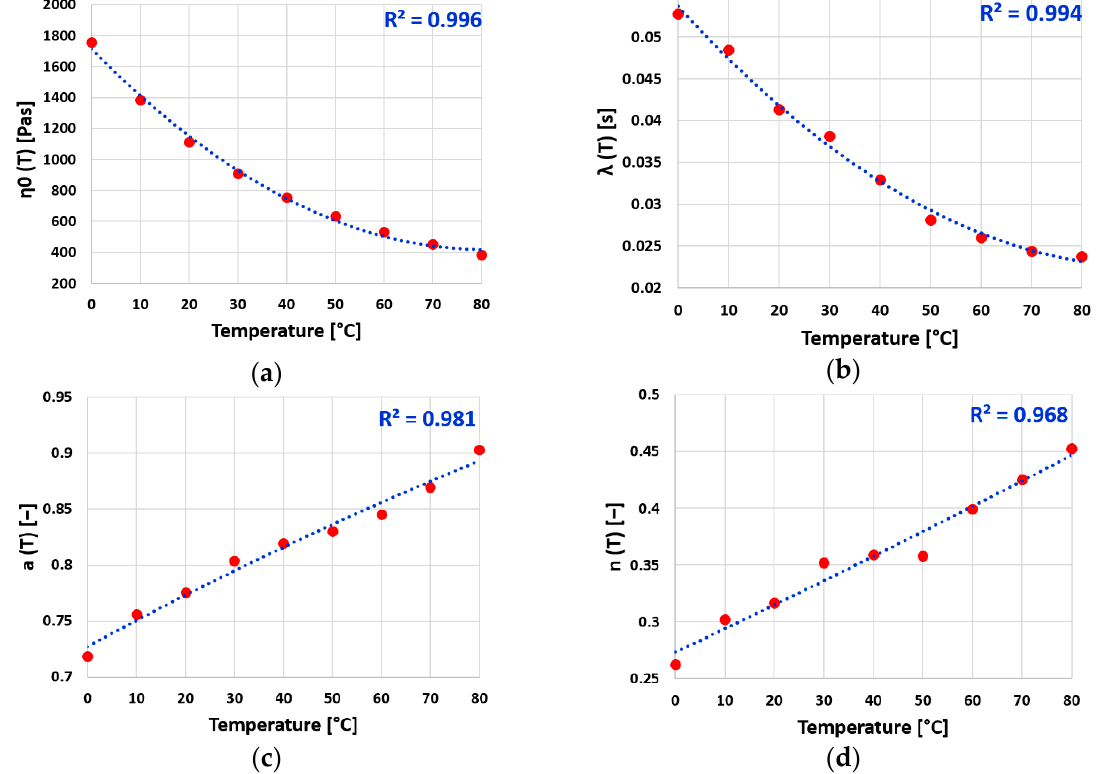
Figure 4. Estimated model parameters (red dots) and fitted model parameter curves (dotted lines) for ( a ) zero-shear dynamic viscosity, ( b ) relaxation time, ( c ) transition control factor and ( d ) power law index.